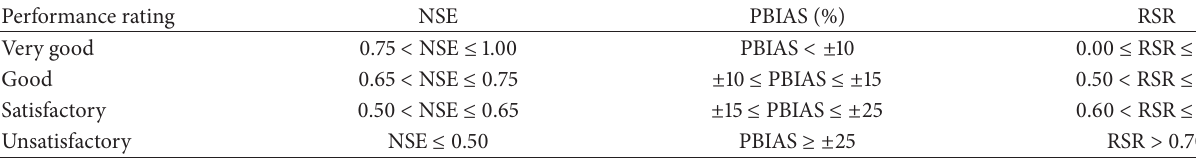
Table 3: Performance rating of evaluation statistic for monthly river discharge.